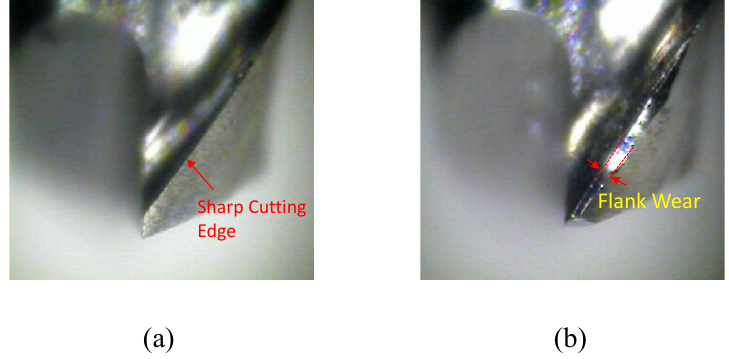
vibration raw signals in the three directions. However, after transforming the raw signal to the time-frequency domain by using wavelet transformation, some changes in the signals correlated to the change in cutting path can be observed, with the wavelet coefficient representing the low-frequency signal. Moreover, as tool wear increases, a more unstable vibration signal can also be observed in the selected wavelet coefficient in Figure 7b. More- over, the Y- and Z-direction vibration signals demonstrate a higher sensitivity to the tool wear than the X-direction signal.